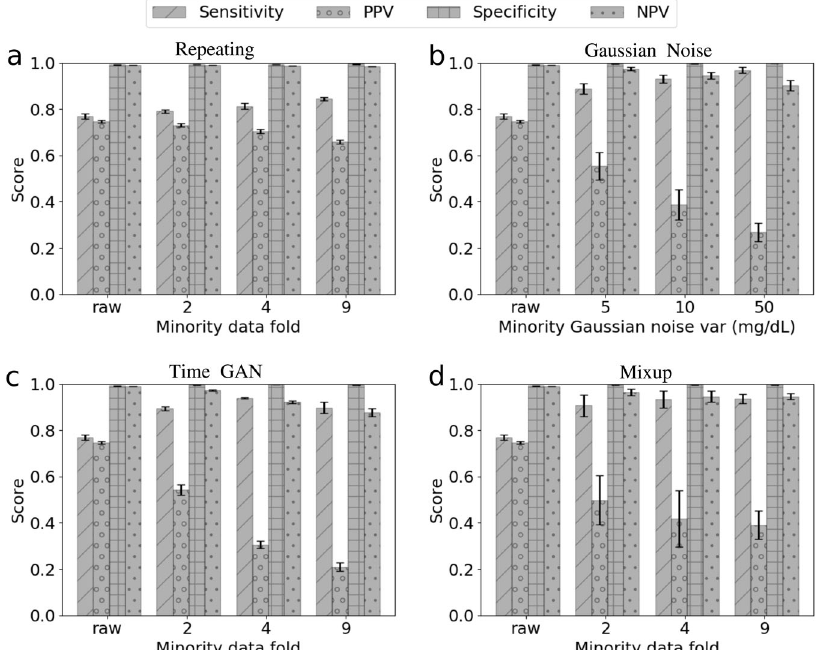
Fig. 6 Predictive scores by different data augmentation methods and different folds of minority data augmentation. Hypoglycemia (the minority class, also the positive class) samples in the training data is augmented with a oversampling by repeating, b Gaussian noise infusion, i.e., the size of the minority training data is doubled by adding a copy of the raw minority data contaminated by Gaussian noises of different levels, c TimeGAN, and d mixup ( α = 2), while “ no hypoglycemia ” (majority class, also the negative class) samples remain intact. The minority data fold represents the number of copies of hypoglycemia samples in the training data after data augmentation. “ Raw ” denotes no data augmentation on the training dataset; twofold denotes that the raw minority data is kept in the training data and another copy of minority data is generated by either repeating or synthesizing in each training epoch. The mean and standard deviation of the classi fi cation metrics are obtained with fi ve different runs. A table recording the detailed numerical results can be found in Supplementary Table 5. Error bars (standard deviation, s.d.) are computed over all patients ’